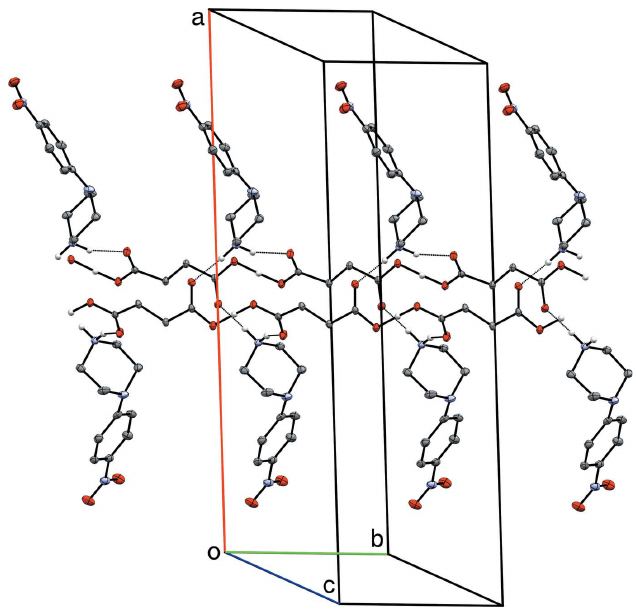
Figure 5 A partial packing plot of I showing extended double chains of O—H (cid:2)(cid:2)(cid:2) O hydrogen-bonded (dotted lines) succinate anions, linked via N—H (cid:2)(cid:2)(cid:2) O hydrogen bonds to the 4-nitrophenylpiperazinium cations. Hydrogen atoms not involved in hydrogen bonds are omitted.